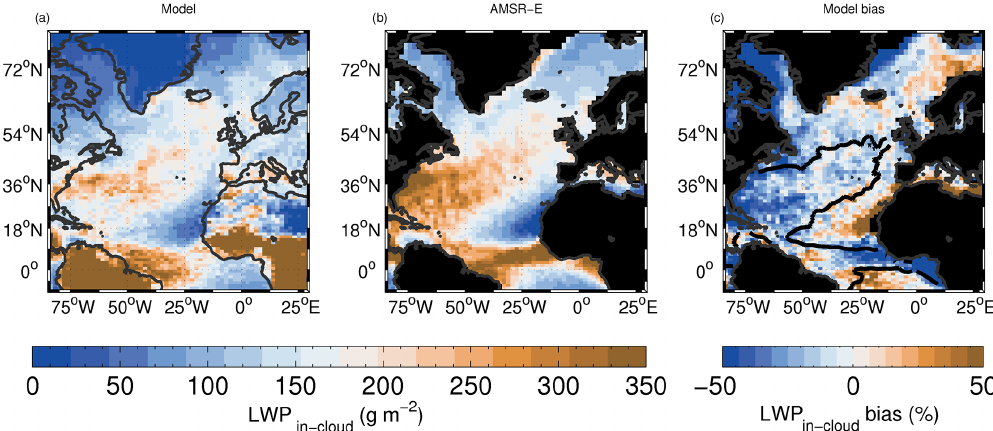
Figure 5. Time-mean in-cloud LWP (LWP ic ) model evaluation for both day and night overpasses. The bias plot on the right includes a contour of the 0.9 value of f LWP ; see Fig. 4 for the full map of f LWP for reference.